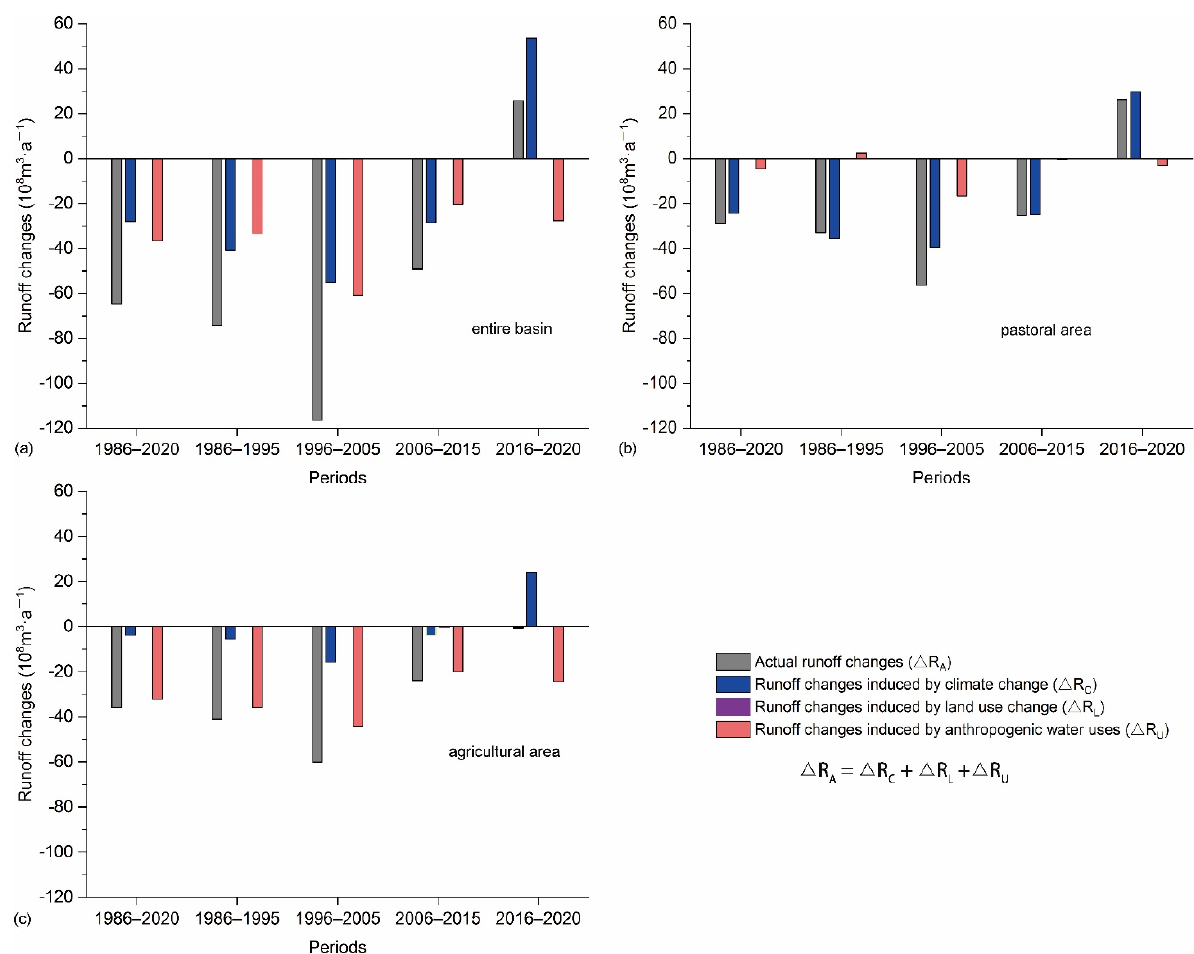
Figure 4. Runoff changes in in the Upper Yellow River Basin during 1986–2020 compared with those in the baseline period (1965–1985). The runoff changes are attributed to climate change ( Δ R C ), land-use change ( Δ R L ) and anthropogenic water consumption ( Δ R U ) in different periods in ( a ) the entire UYRB, ( b ) pastoral area and ( c ) agricultural area, respectively.